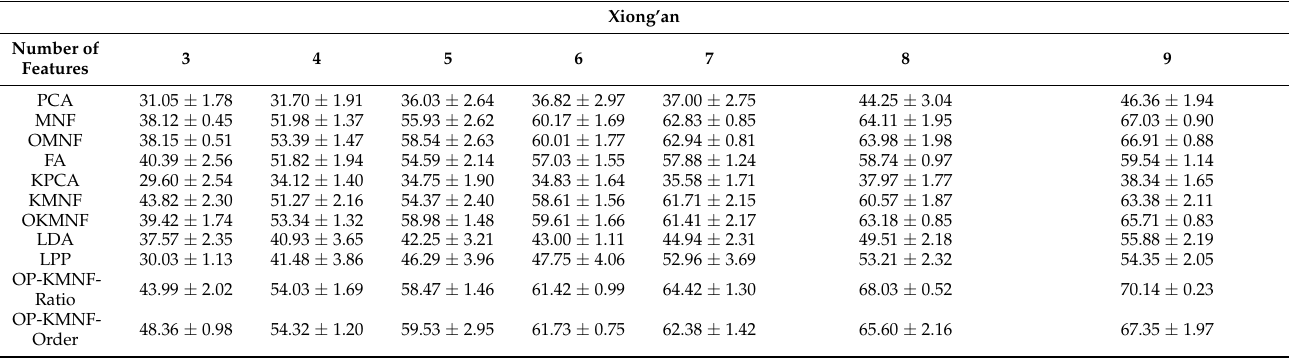
Table 6. The class accuracies of SVM classification on Xiong’an with number of features = 9. All the results are percentages. Classes